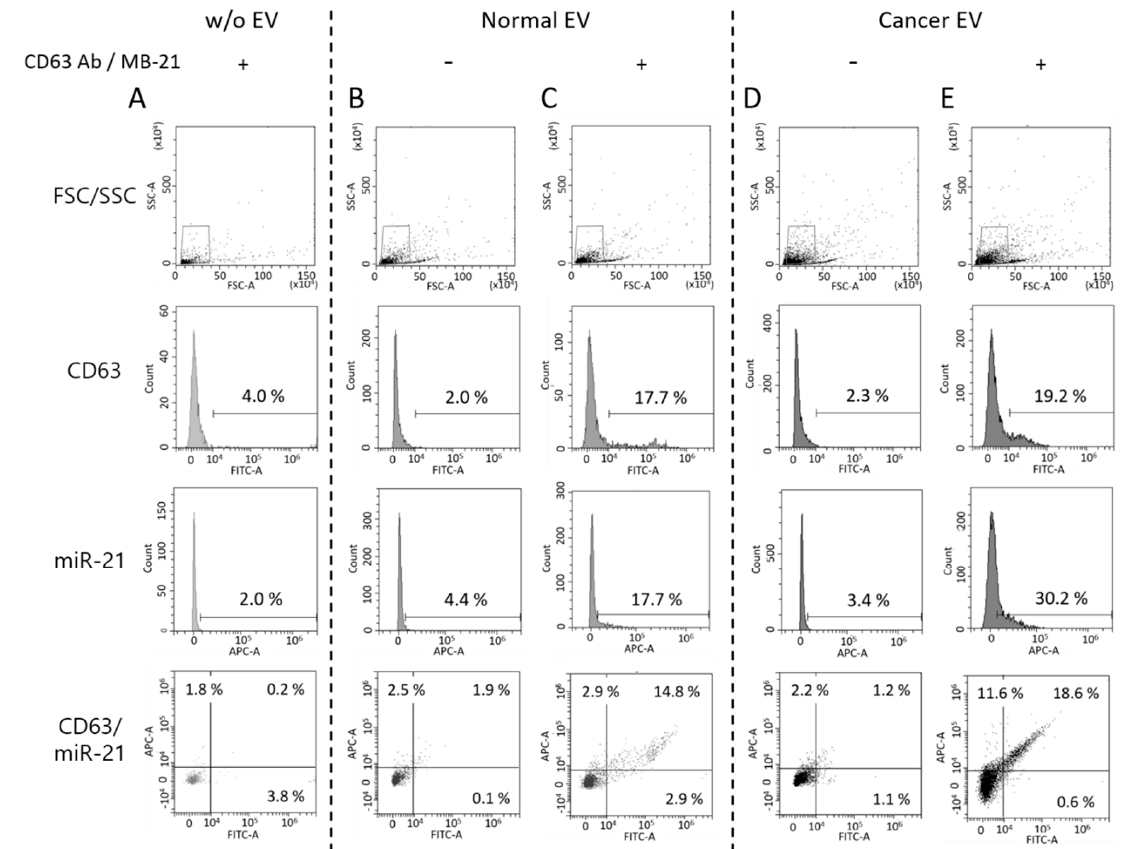
Figure 5. Single step detection of EV surface proteins and miRNAs using flow cytometry. Flow cytometric analysis was performed for simultaneous detection of EV CD63 and miR-21 in a single step. Forward versus side scatter (FSC/SSC) gatings are shown in the top panel. ( A ) Representative flow cytometric results for non-EV control with CD63 antibody and MB-21 ( B , C ) Representative flow cytometric results for normal EV biomarker detection without ( B ) and with ( C ) CD63 antibody and MB-21. CD63 and miR-21 fluorescent signals from normal EVs without detection probes were used as background controls. The numbers in the quadrant plot of CD63 (x-axis) and miR-21 (y-axis) represent the percentages of each population, which indicated that there was an increase in the number of CD63 and miR-21 positive EVs. ( D , E ) Single step in situ detection of CD63 and miR-21 in cancer EVs. Fluorescent signals were observed for cancer EVs in the absence ( D ) and presence ( E ) of CD63 antibody and MB-21. There was an increase in the percentages of miR-21 positive EVs in the cancer EVs, as compared to that in the normal EVs. As a result, a higher population of EVs positive for both CD63 and miR-21 was